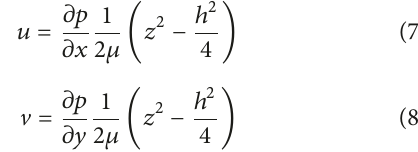
Figure 2: A cell in three dimensions and its neighbouring